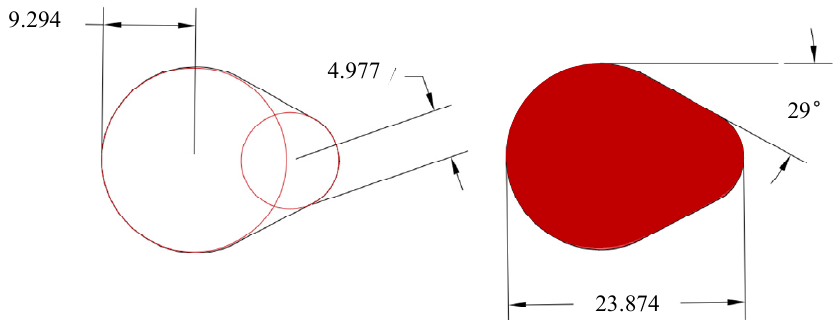
Figure 14. Rotor cutout dimension and general geometry (dimensions are in mm).